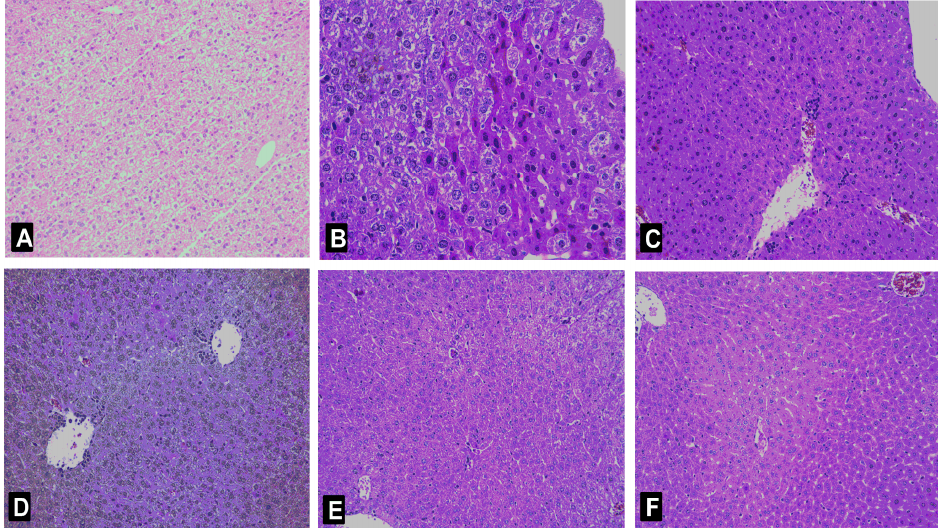
Figure 3. Histological analysis of the livers after Con A administration. Typical images were chosen from the different experimental groups (original magnification 10 × 20). ( A ) Control group; ( B ) Con A-treated group; ( C ) Con A and DDB (150 mg/kg bw)-treated group; ( D ) Con A and nicotiflorin (25 mg/kg bw)-treated group; ( E ) Con A and nicotiflorin (50 mg/kg bw)-treated group; and ( F ) Con A and nicotiflorin (100 mg/kg bw)-treated group.